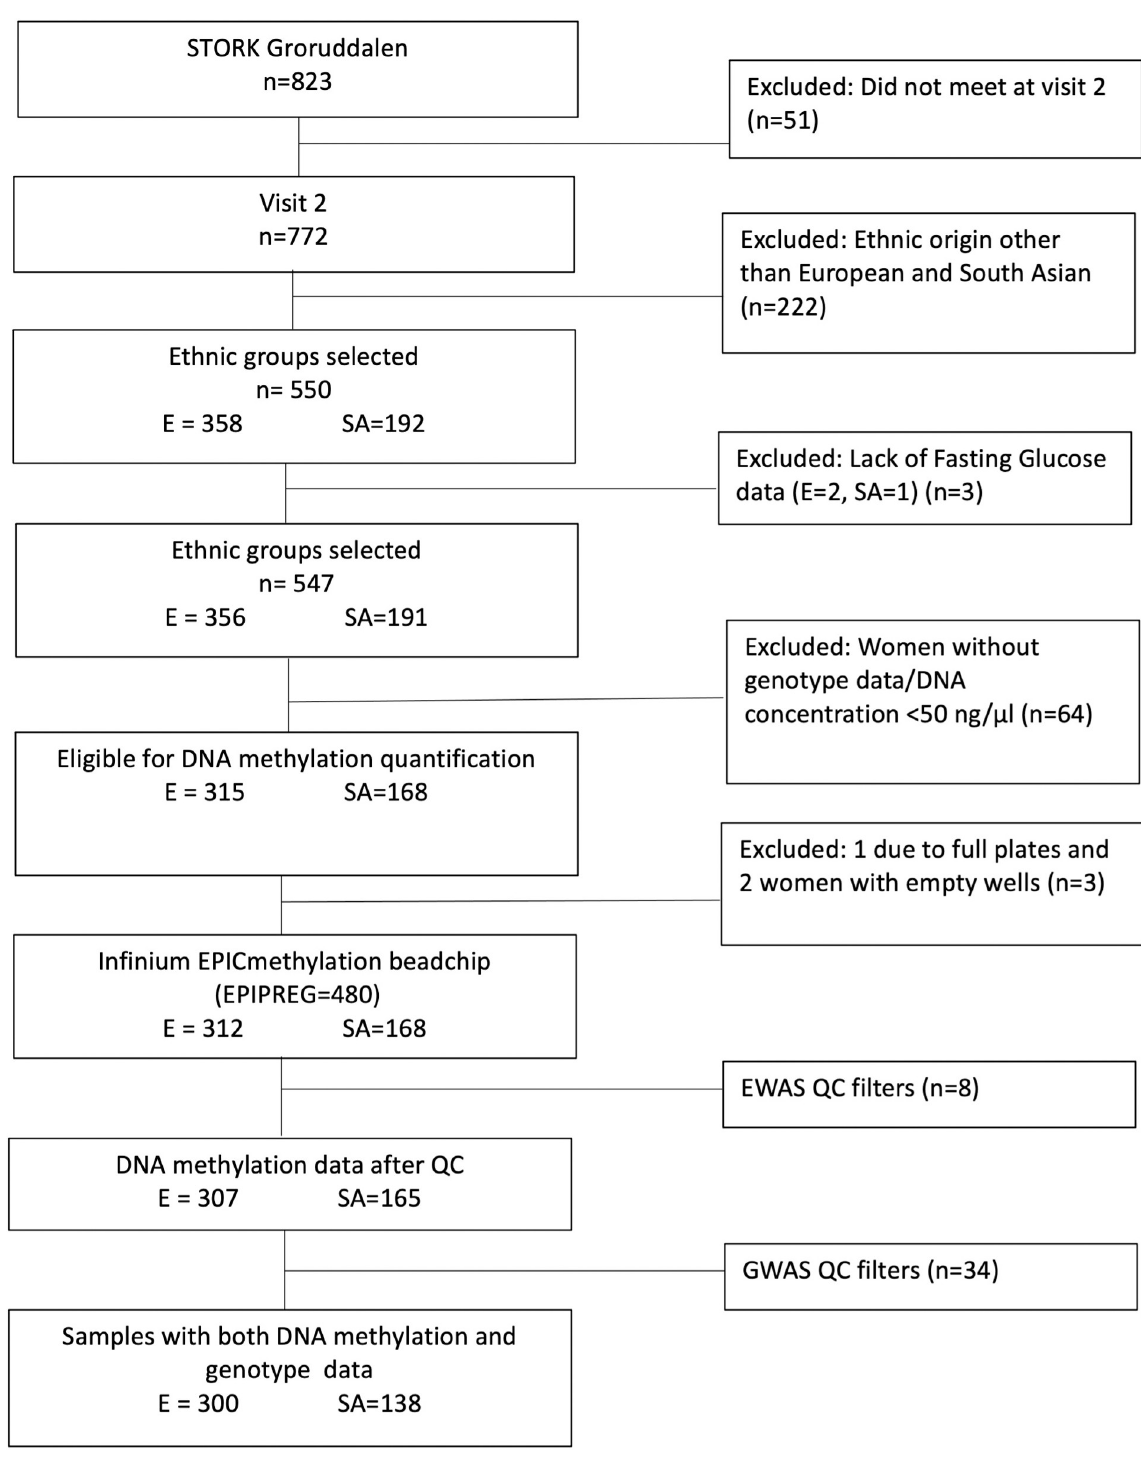
Fig 1. Flow chart of the EPIPREG sample. E = European, SA = South Asian.